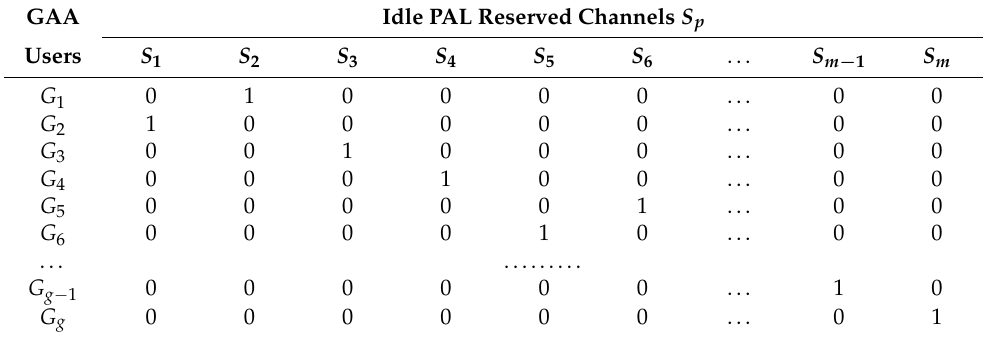
Table 2. Idle spectrum